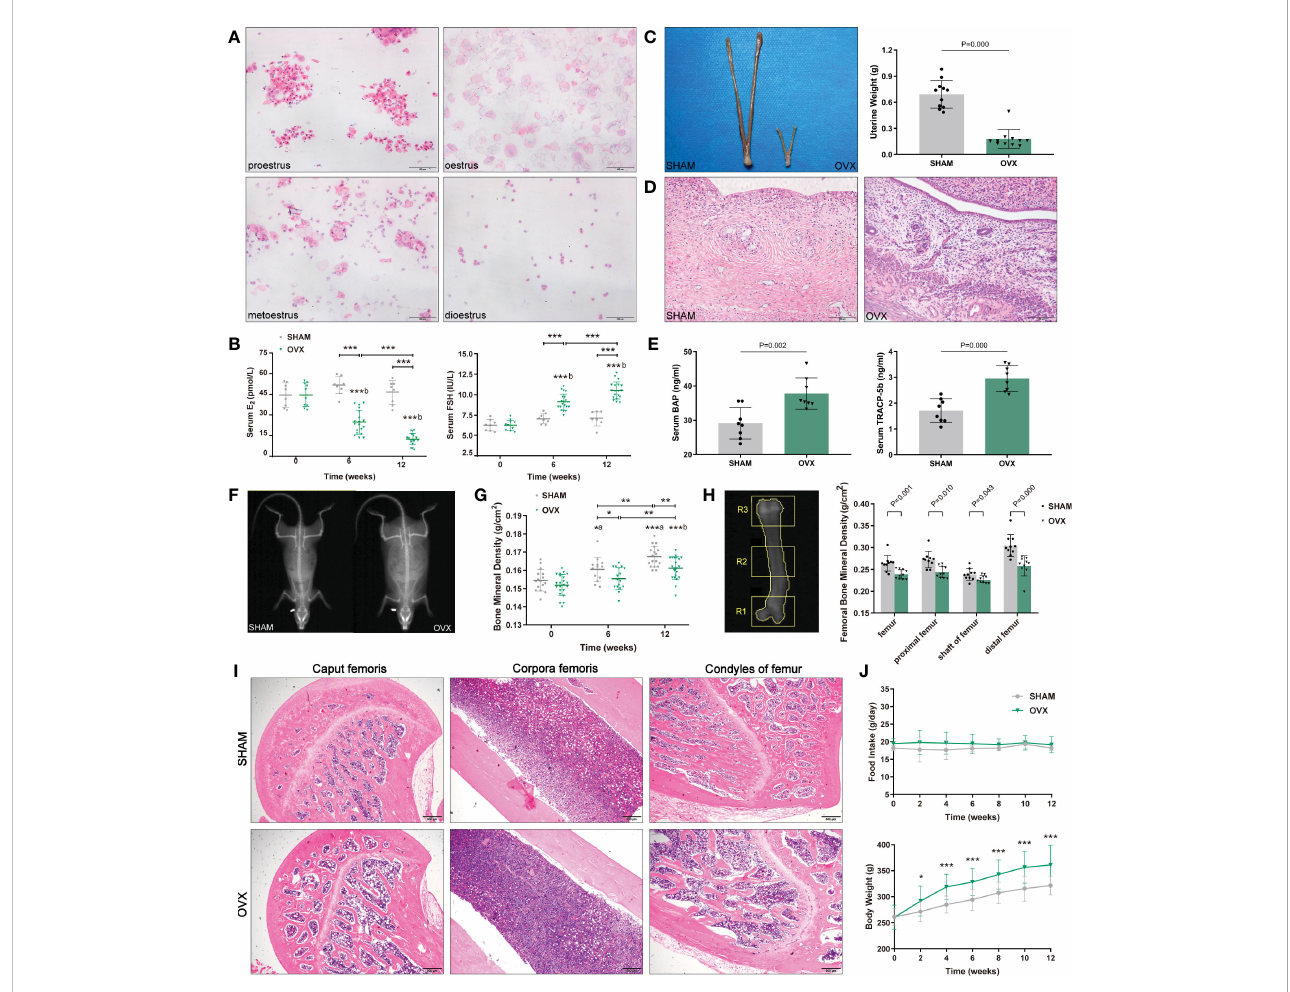
FIGURE 1 Identi fi cation of osteoporosis model in OVX rats. (A) 4 sequential stages of vaginal exfoliated cells in regular estrous cycle with H&E. Scale bar, 100 m m. (B) Serum hormone levels (E 2 , FSH). n ≥ 8 in each group. (C) Uterine size and weight. n=11. (D) Endometrial and myometrium with H&E. n=11. Scale bar, 100 m m. (E) Serum bone metabolism markers (BAP, TRACP-5b). n=8. (F) The whole-body composition analysis by DXA. (G) BMD of the whole-body